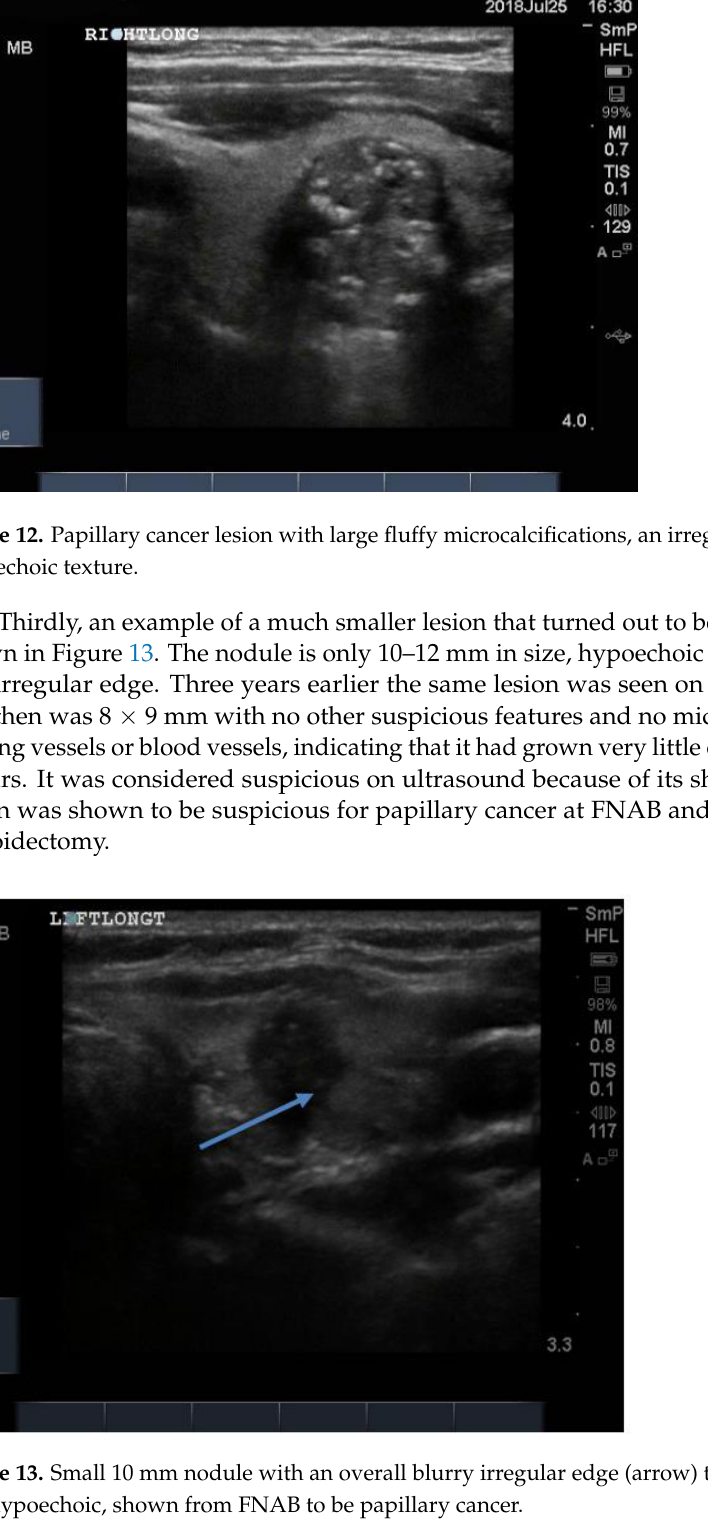
Figure 13. Small 10 mm nodule with an overall blurry irregular edge (arrow) that is taller than wide and hypoechoic, shown from FNAB to be papillary cancer.